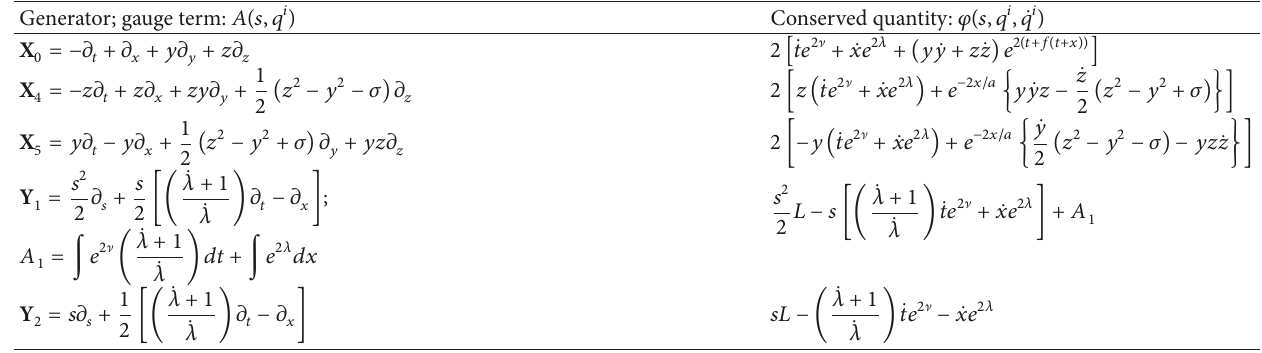
Table 19: Conserved quantities corresponding to each Noether symmetry.